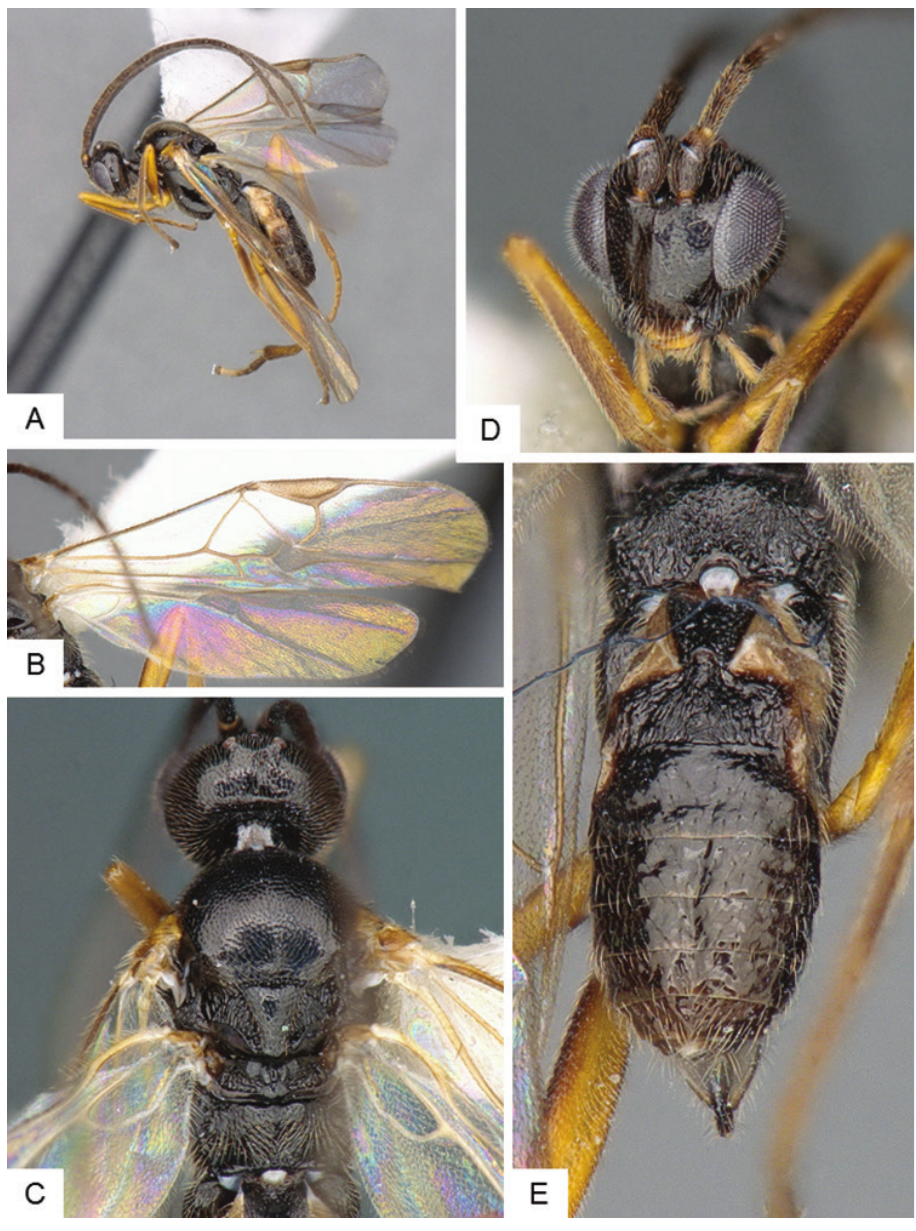
Figure 13. Glyptapanteles fulvipes . A Habitus, lateral B Fore wing and hind wing C Head and meso- soma, dorsal D Head, frontal E Metasoma,